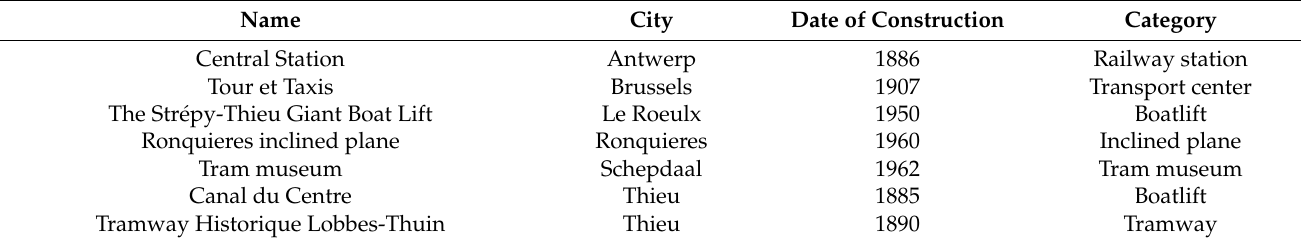
Table 6. The representative Belgium industrial heritage sites in transportation in